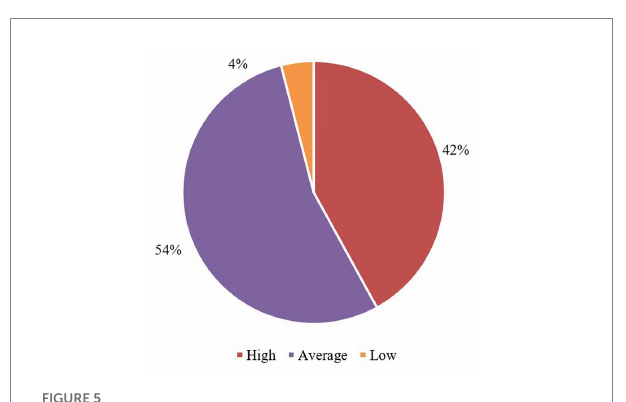
FIGURE 5 Answers to the question: please, rate your motivation for learning. Source: compiled by the authors.